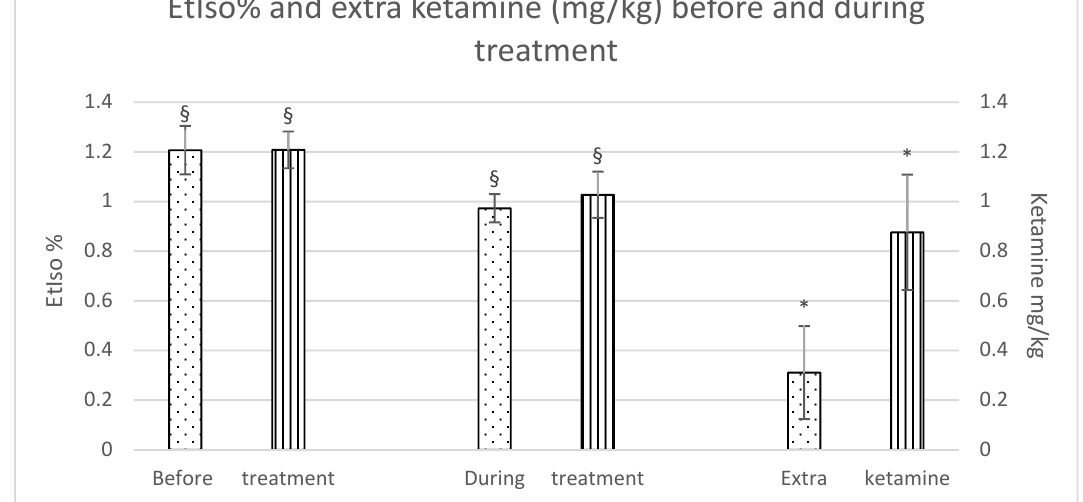
Figure 1. EtIso% and extra ketamine (mg/kg) before and during treatment (fentanyl dots, control stripes). p < 0.05. * = significantly different between groups; § = significantly different before and during treatment.